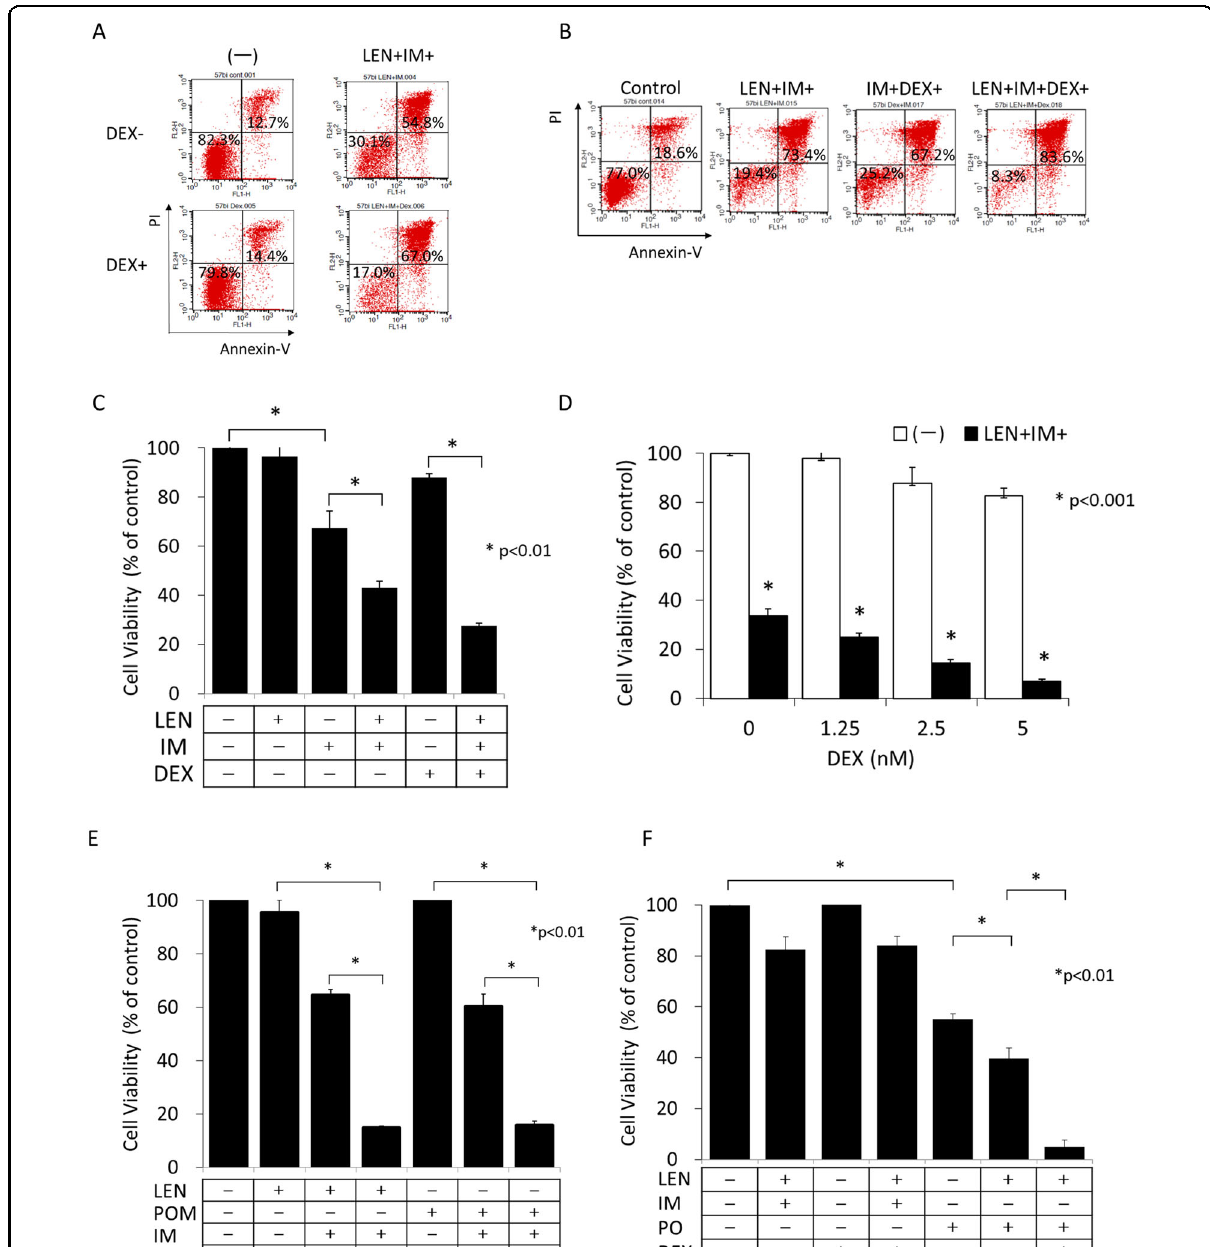
Fig. 8 Effect of DEX for inducing apoptosis of KOPN57bi cells. A Flow cytometric analysis of DEX effect on LEN plus IM-induced apoptosis. KOPN57bi cells were cultured for 48 h in the presence or absence of LEN (5 μ M) plus IM (0.5 μ M) with or without the addition of 2.5 nM DEX (SIGMA- Aldrich), and fl ow cytometric analysis was performed after Annexin-V/PI staining. B Comparative analysis of apoptosis-inducing effects between 2- drugs and 3-drugs. KOPN57bi cells were cultured for 48 h in the presence or absence of LEN (5 μ M) plus IM (0.5 μ M), IM plus DEX (2.5 nM), or LEN plus IM plus DEX, and fl ow cytometric analysis was performed after Annexin-V/PI staining. The X and Y axes shown in A and B indicate log fl uorescence intensities of Annexin-V and PI, respectively. C Effect of DEX on LEN plus IM-induced cytotoxicity. KOPN57bi cells were cultured for 48 h in the presence or absence of LEN (5 μ M) plus IM (0.5 μ M) with or without the addition of DEX (2.5 nM) and alamarBlue cytotoxic assays were performed. D Dose-dependent effect of DEX on LEN plus IM-induced cytotoxicity. KOPN57bi cells were cultured for 48 h in the presence or absence of LEN (5 μ M) plus IM (0.5 μ M) with different concentrations (0, 1.25, 2.5, and 5 nM) of DEX, and alamarBlue cytotoxic assays were performed. E Comparative analysis of LEN and POM in 2-drugs and 3-drugs-induced cytotoxicity. KOPN57bi cells were cultured for 48 h in the presence or absence of LEN (5 μ M), POM (2.5 μ M), or IM (0.5 μ M) with or without the addition of DEX (2.5 nM), and alamarBlue cytotoxic assays were performed. F Synergistic effect of LEN, PO, and DEX on cytotoxicity in SU/SR cells harboring T315 I mutation. The Ph + SU/SR cells with T315I mutation were cultured for 48 h in the presence or absence of PO (5 nM) alone or LEN (5 μ M) plus PO with or without the addition of DEX (2.5 nM), and alamarBlue cytotoxic assays were performed. Of fi cial journal of the Cell Death Differentiation